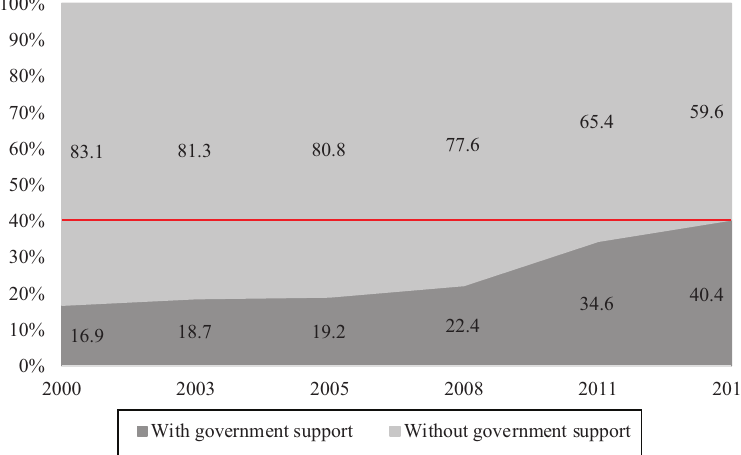
Figure 5. Percentage